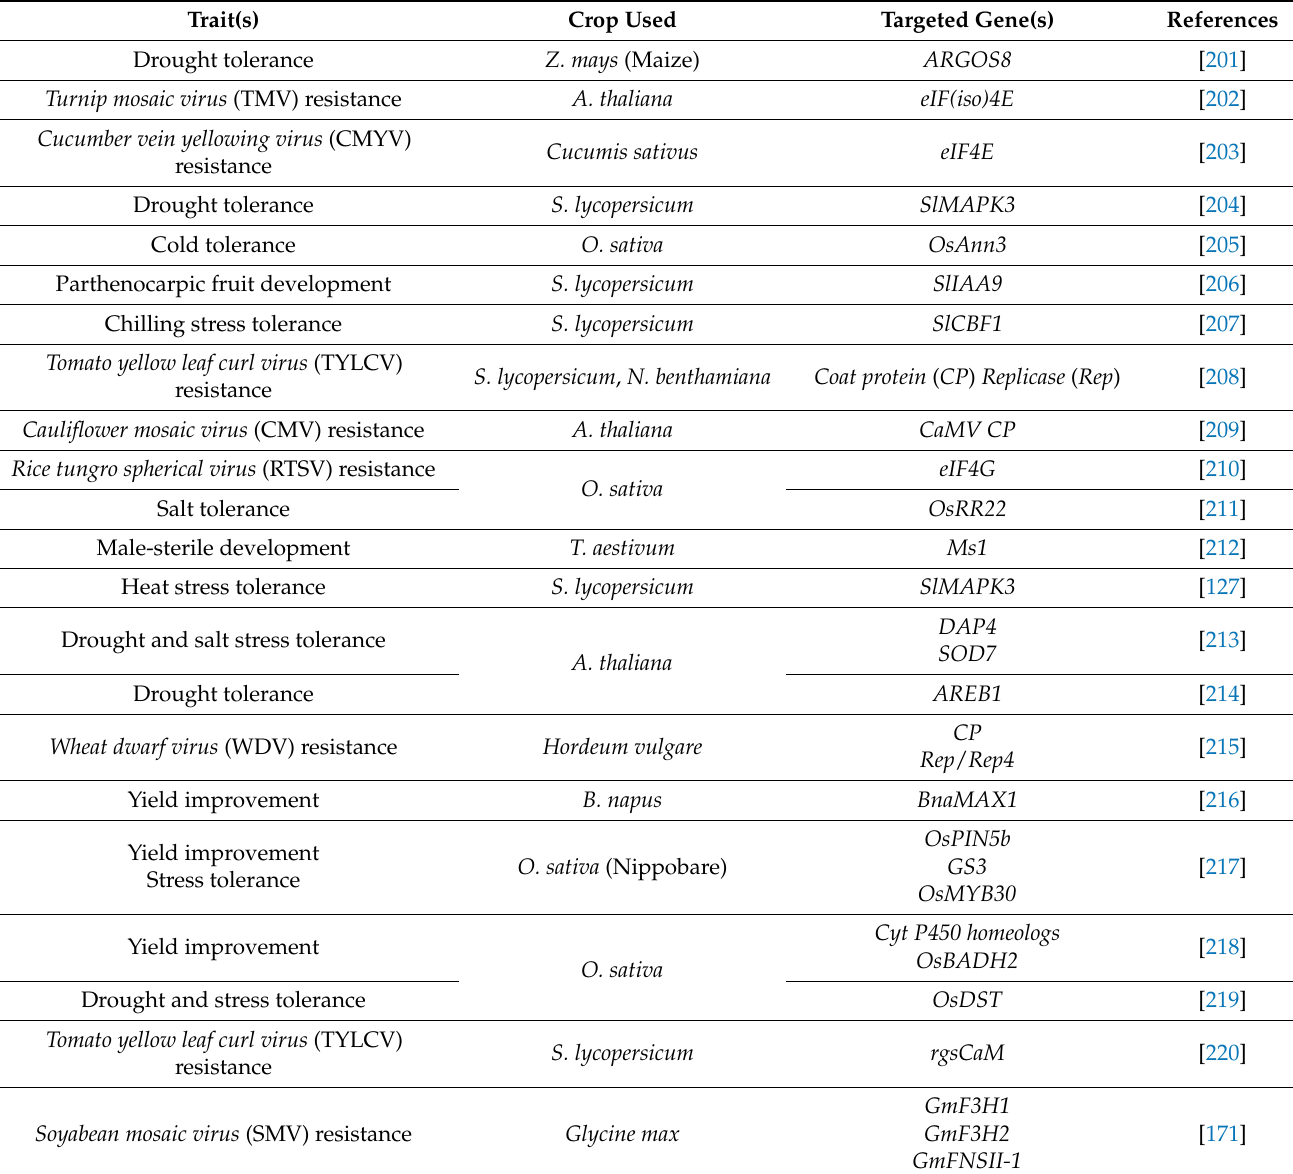
Table 2. CRISPR/Cas9 system-mediated gene editing in